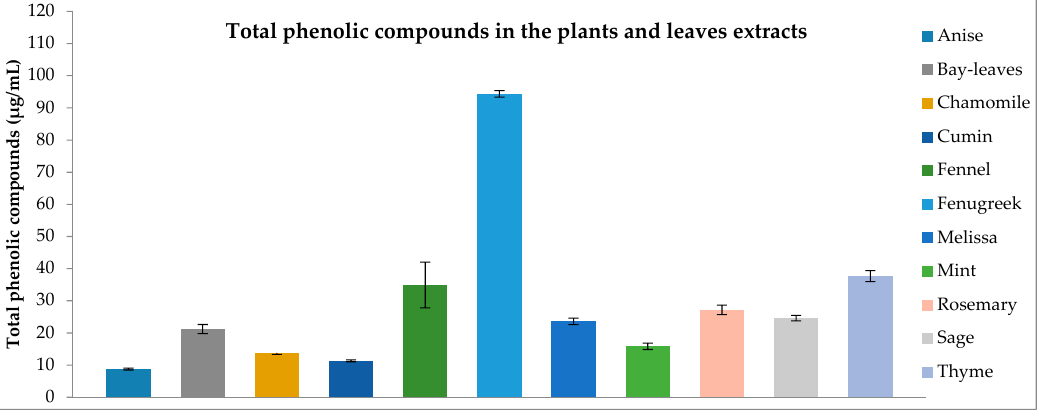
Figure 1. Total phenolic content of the plant and leaves extracts determined by the Folin-Ciocalteu assay and calculated as GAE in µg g − 1 extract based on dry weight. Results are the average of triplicates ± SD (Standard Deviation). Abbreviations: GAE: Gallic acid Equivalent.